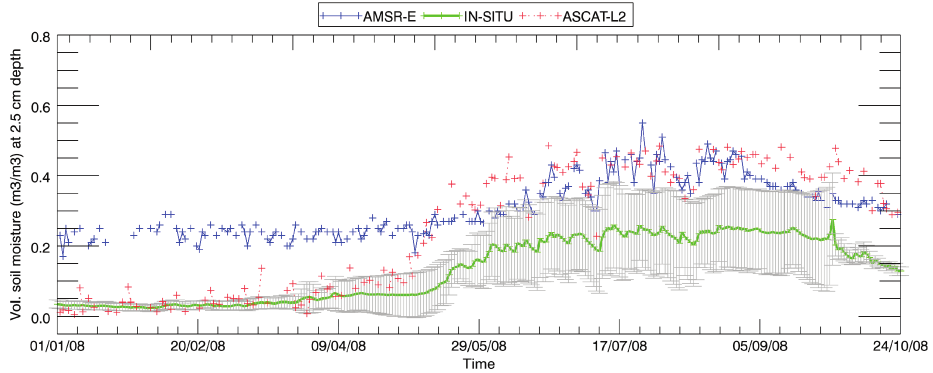
Fig. 3. Soil moisture retrievals from AMSR-E (blue) and ASCAT-L2 (red) compared to in situ measured soil moisture at a 2.5cm soil depth in Naqu network area (green line with range (error bars) given by one standard deviation around the mean).